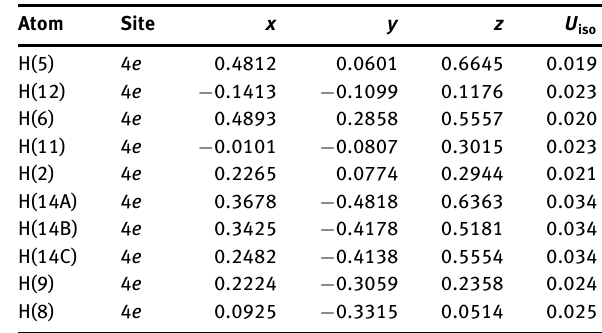
Table 2: Fractional atomic coordinates and isotropic or equivalent isotropic displacement parameters (Å 2